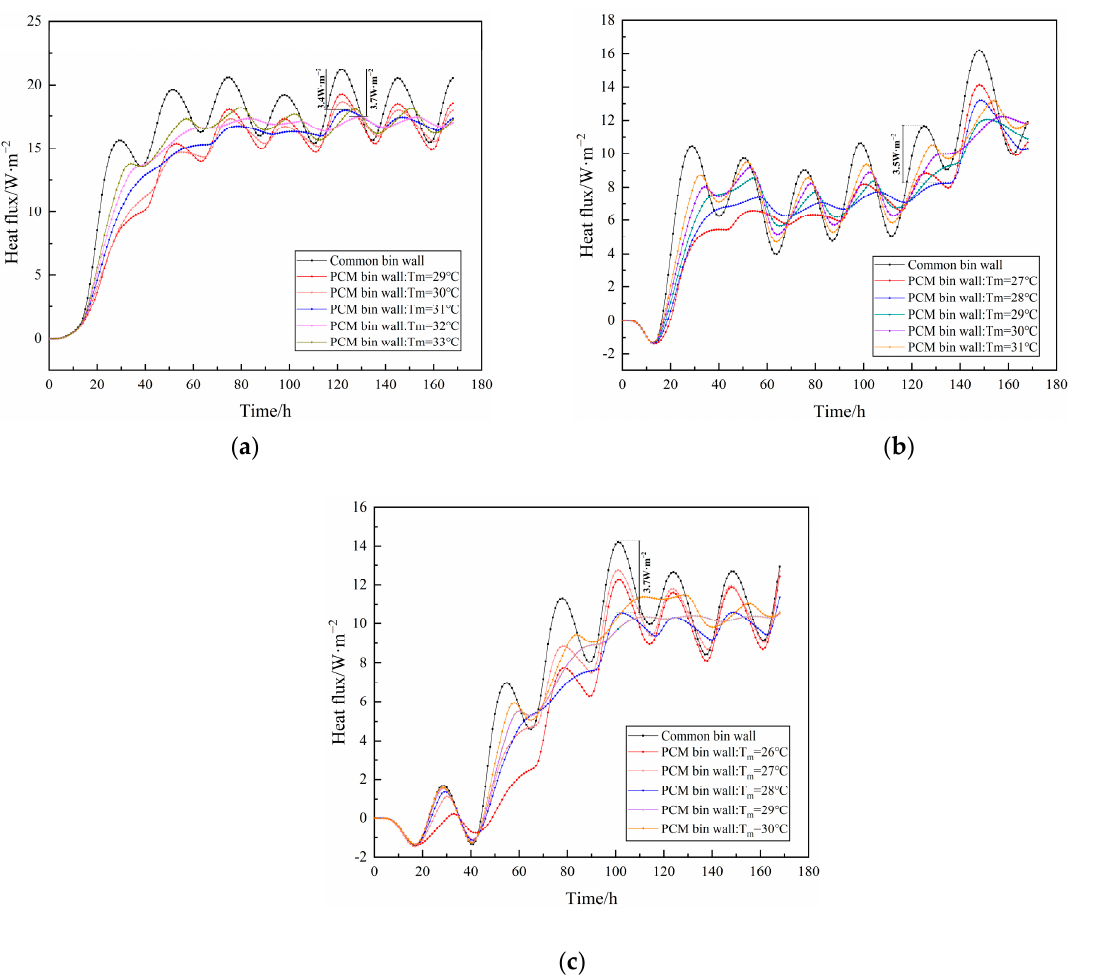
Figure 9. The indoor heat fluxes distribution of PCM bin wall. ( a ) Guangzhou. ( b ) Zhengzhou. ( c ) Harbin.